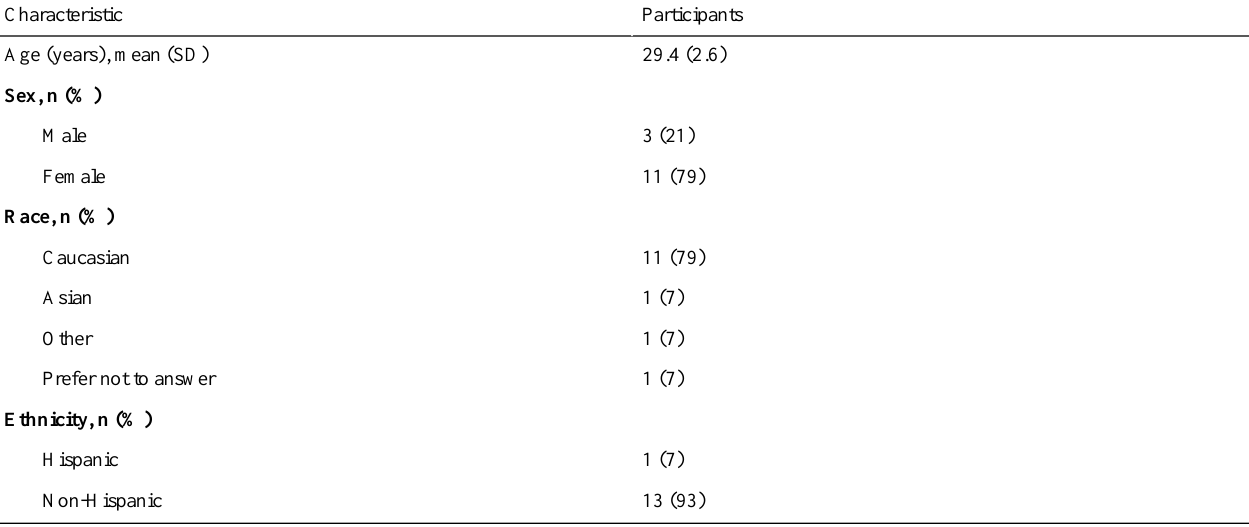
Table 1. Participant demographic data (N=14).